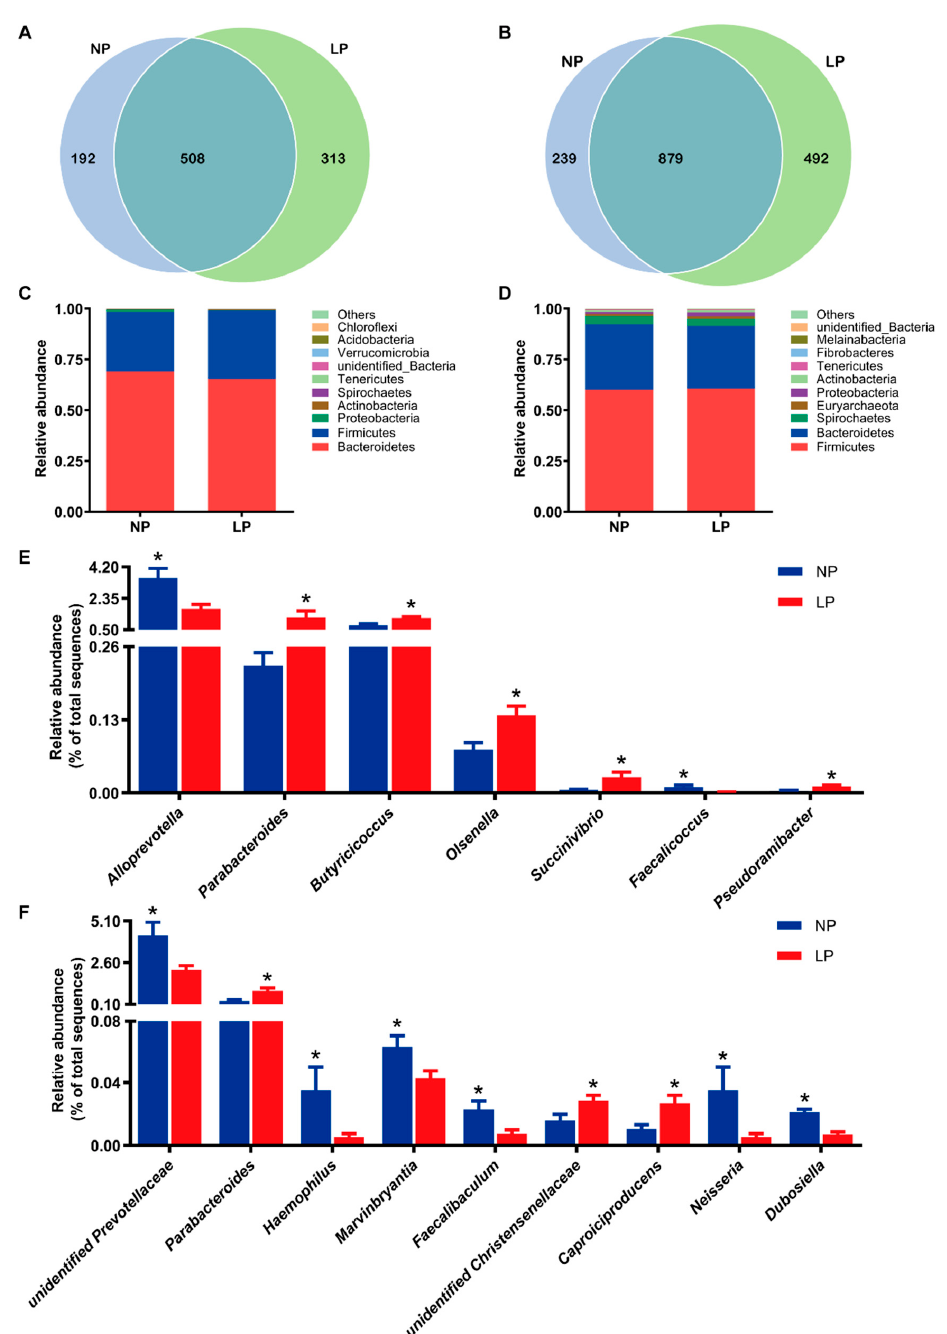
Figure 1. Effects of protein restriction and realimentation on the gut microbiota in the colonic digesta of piglets. Venn diagram showing the unique and shared OTUs between groups at day 14 ( A ) and the end of the experiment ( B ). Stacked bar chart depicting the relative abundance of top 10 phylum between groups at day 14 ( C ) and the end of the experiment ( D ). Bar chart showing the significantly changed bacteria genera between groups at day 14 ( E ) and the end of the experi- ment ( F ). * p -value < 0.05. NP, normal protein group. LP, low protein group.